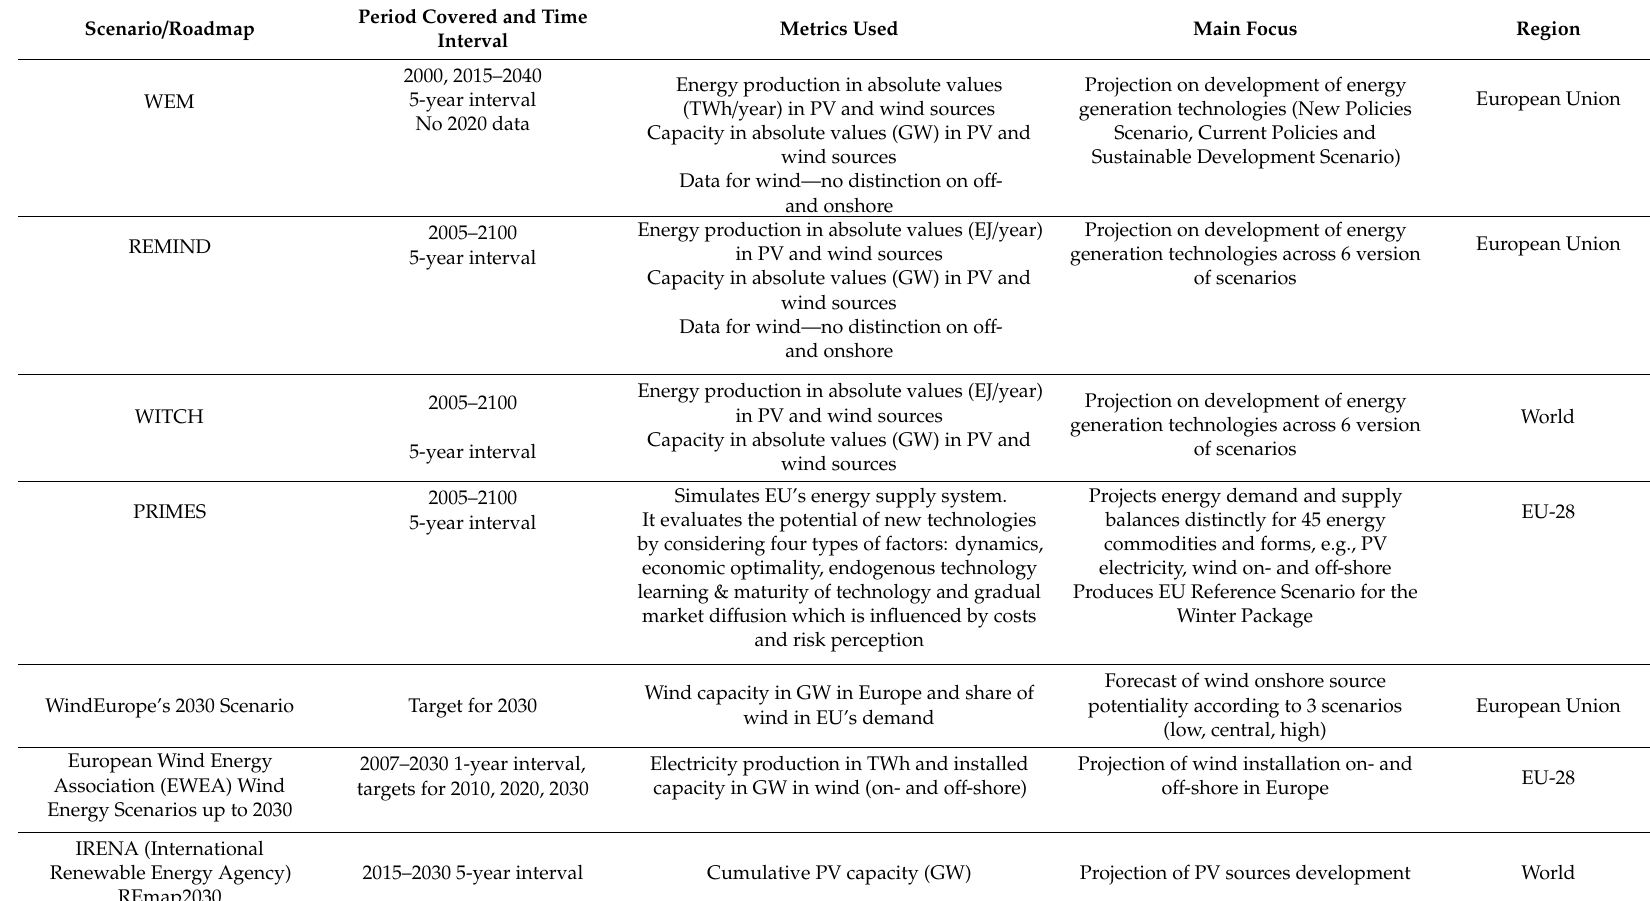
Table 5. Models and scenarios gaps and inconsistences limiting the analyzes for power sector